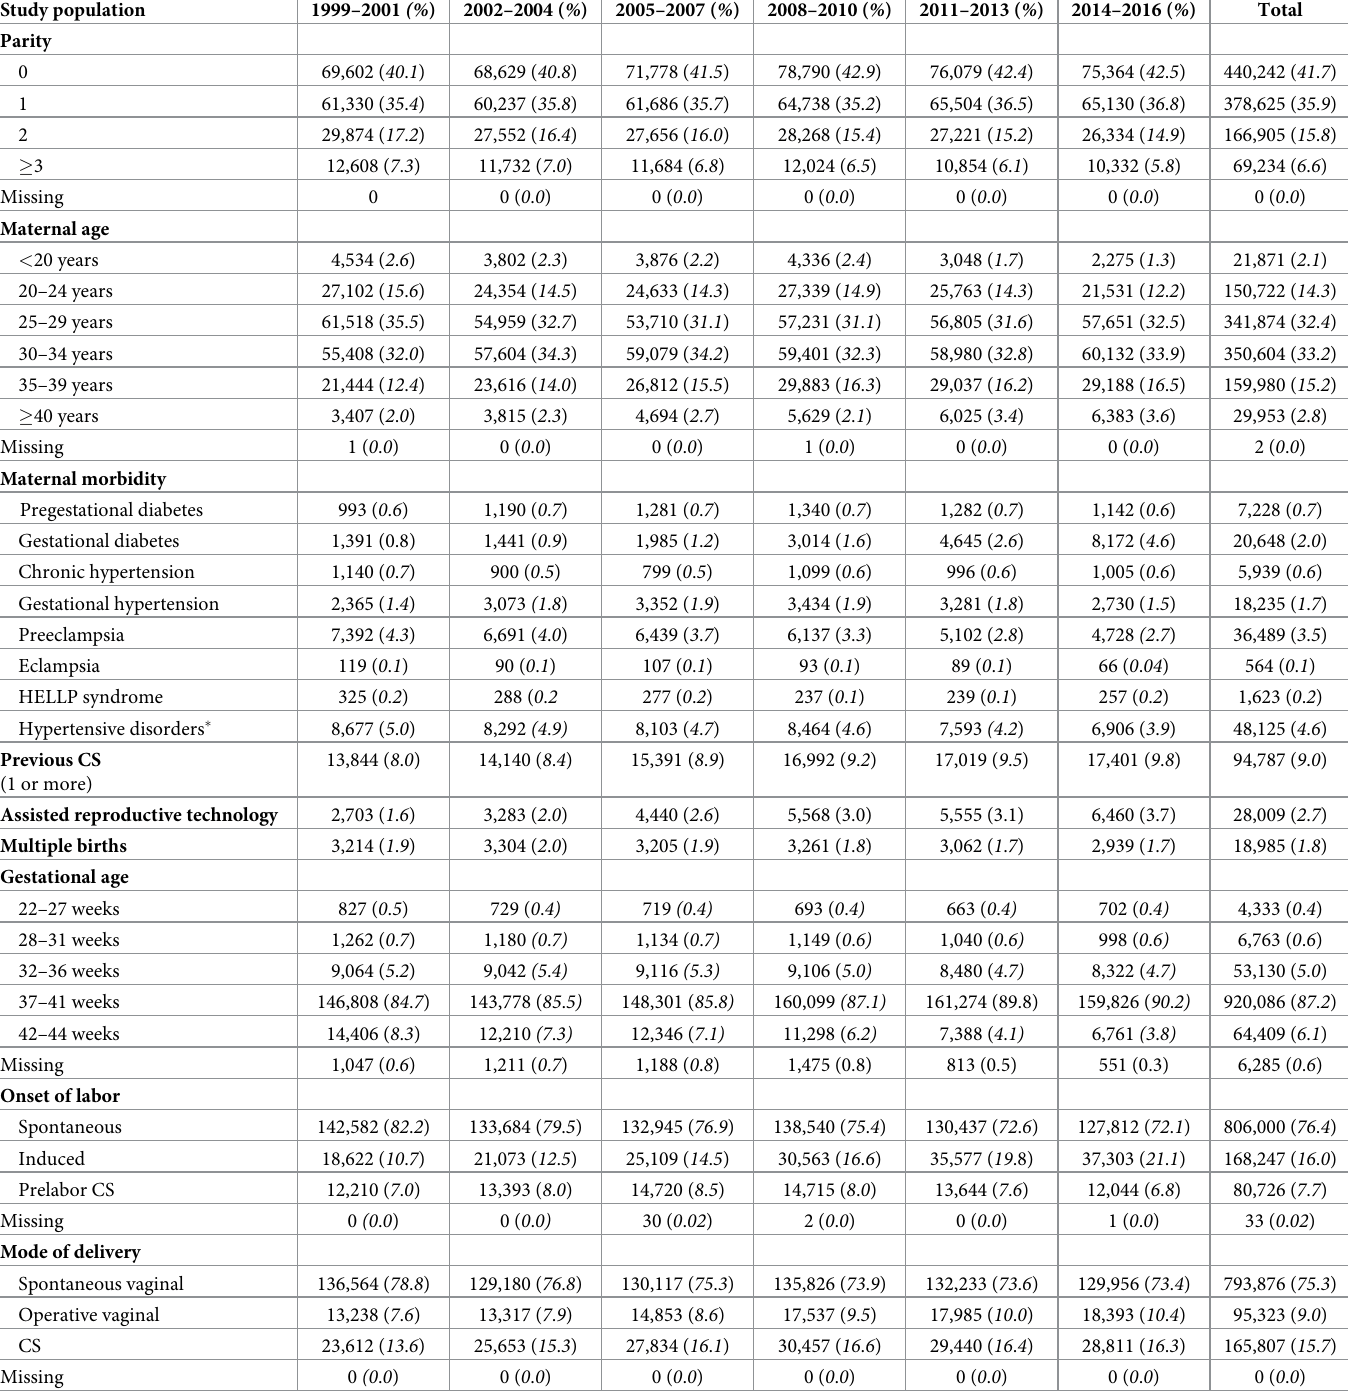
Table 1. Characteristics of the study sample, stratified by 3-year time